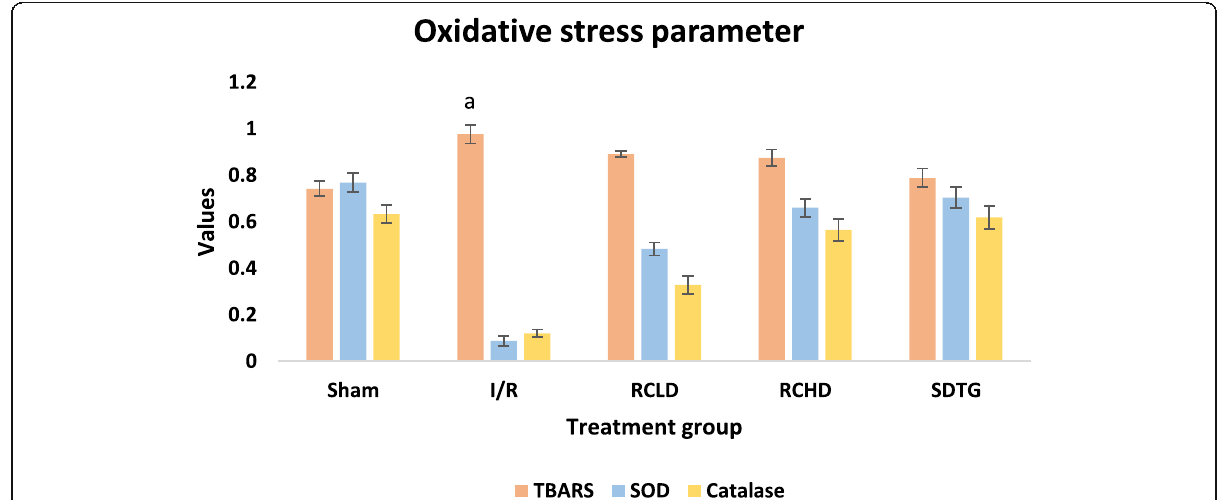
Fig. 6 Oxidative stress parameter in the different treatment groups. Where, values are indicated as mean ± SEM; ( n = 5) in each group. Data were subjected to one-way ANOVA followed by Dunnett ’ s test when RCLD, RCHD, and SDTG groups were compared to the I/R group, while the I/R group was compared to the Sham group. a p < 0.01, when compared to Sham group, b p < 0.05, c p < 0.01, d p < 0.001 when compared to I/R group. The catalase was expressed n moles of H 2 O 2 consumed/minute/mg protein, SOD was expressed as SOD units per mg of protein. The unit of TBARS is TBARS (nmoles/wet